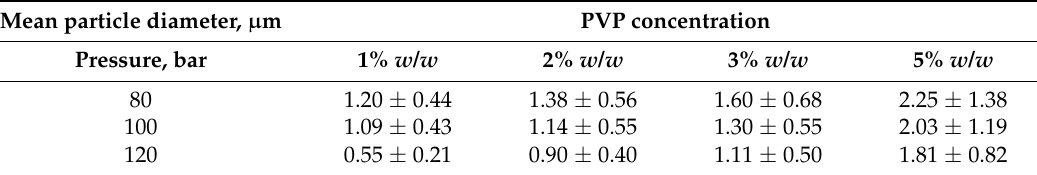
Table 1. Mean particle diameter and standard deviation for the experiments performed in this study. PVP: